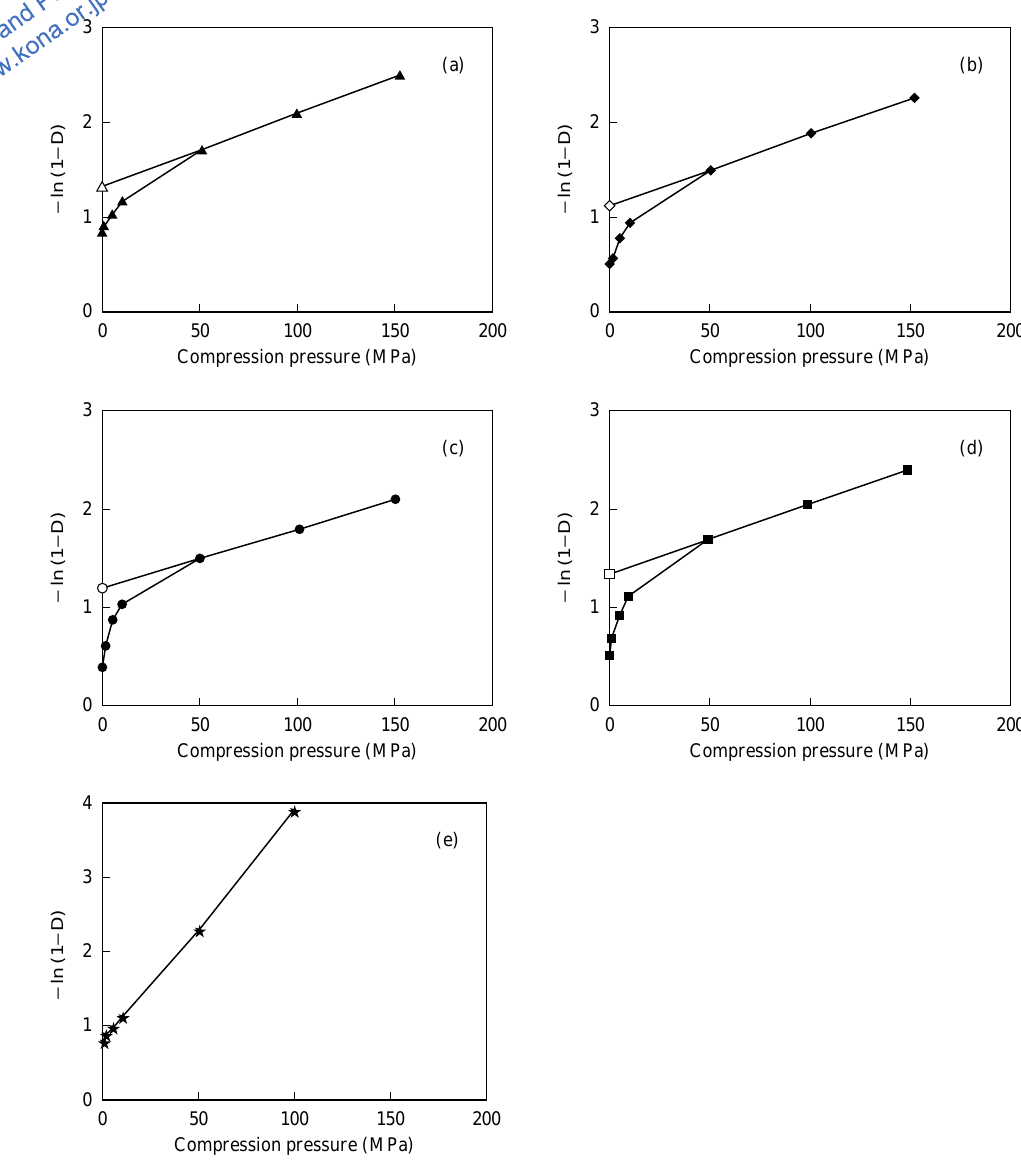
Fig. 3 Heckel’s plot for ascorbic acid and potassium chloride crystals at a compression speed of 10 mm min (cid:4) 1 Straight lines were obtained by a linear regression analysis of data between 50 and 150 MPa. (a) Original coarse crystals, (b) C97 gran- ules, (c) SA agglomerated crystals, (d) ESD agglomerated crystals, and (e)